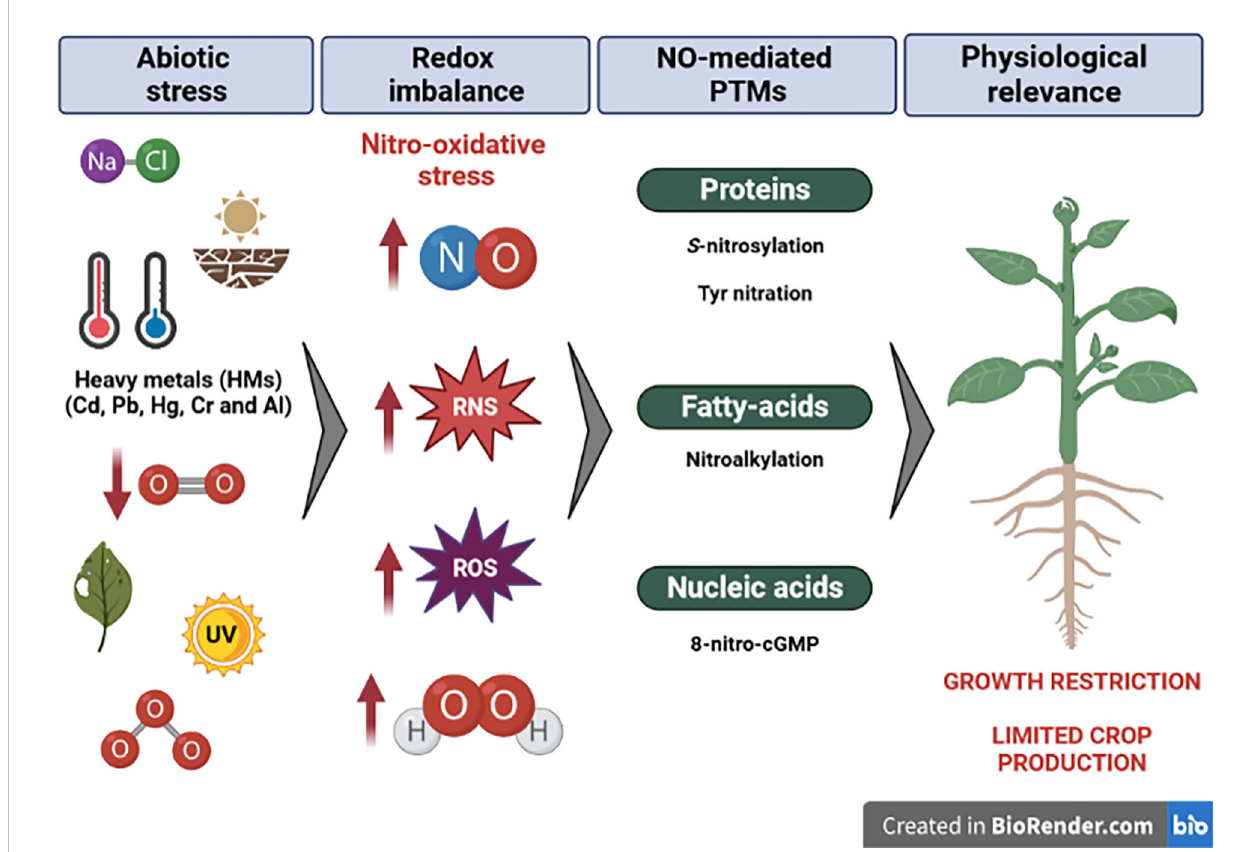
FIGURE 2 Different abiotic situations promote a redox imbalance linked to nitro-oxidative stress. Plant adaptation implies molecular strategies triggered by NO modi fi cations to alleviate negative effects to readjust their growth and development. Created by